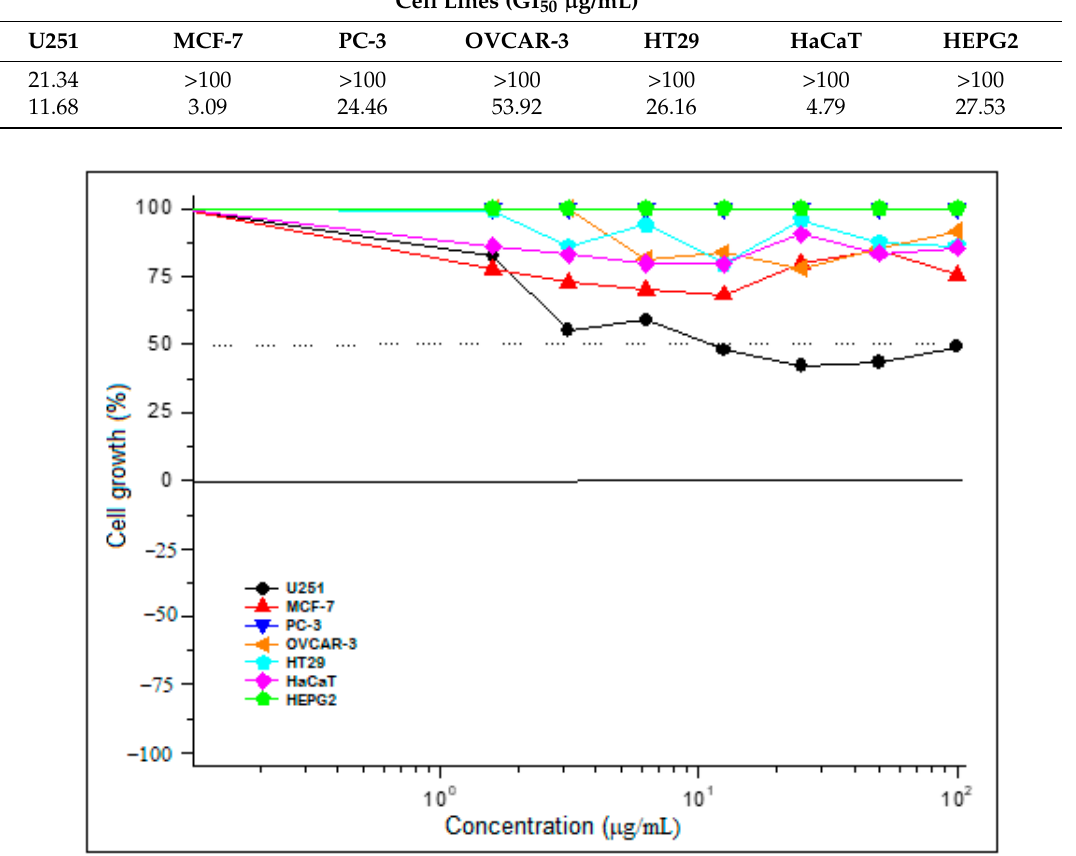
Figure 3. Growth inhibition of the tumor cell lines after LFP-E extract treatment (48